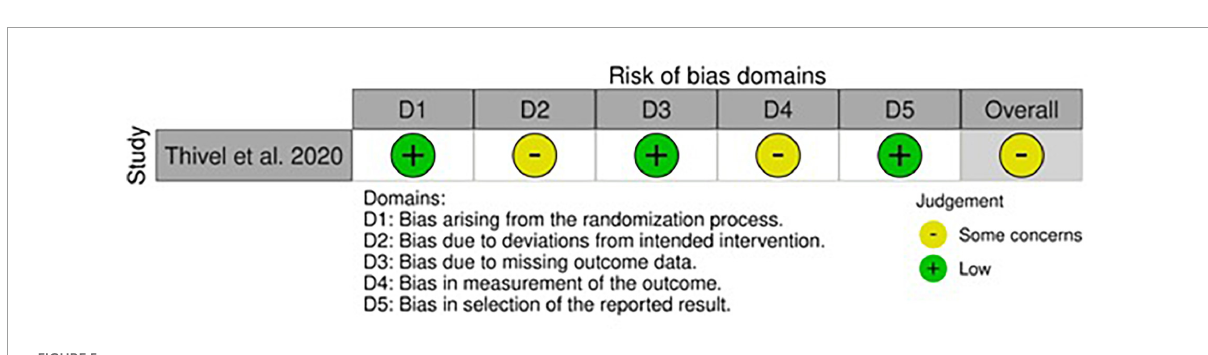
FIGURE5 Risk of bias within RCTs in children and